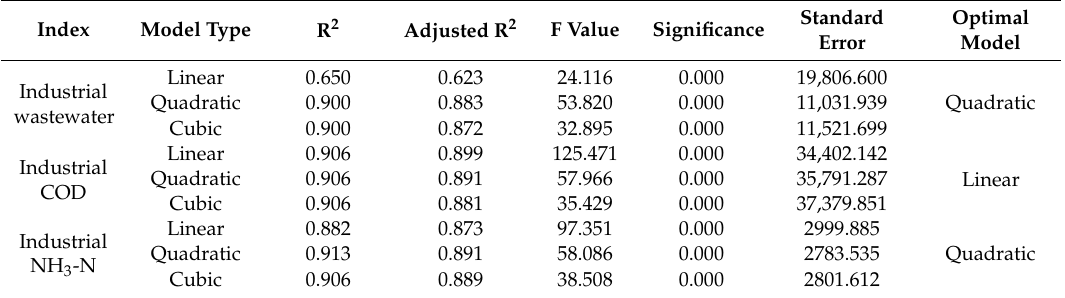
Table 3. Optimal environmental Kuznets curve (EKC) model between industrial pollutants emission and economic growth.